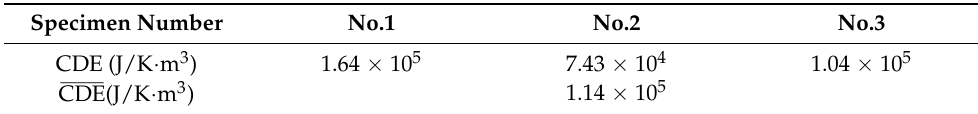
Table 5. The cumulative damage entropy (CDE) of three specimens and CDE when the stress amplitude is 148.5 MPa.